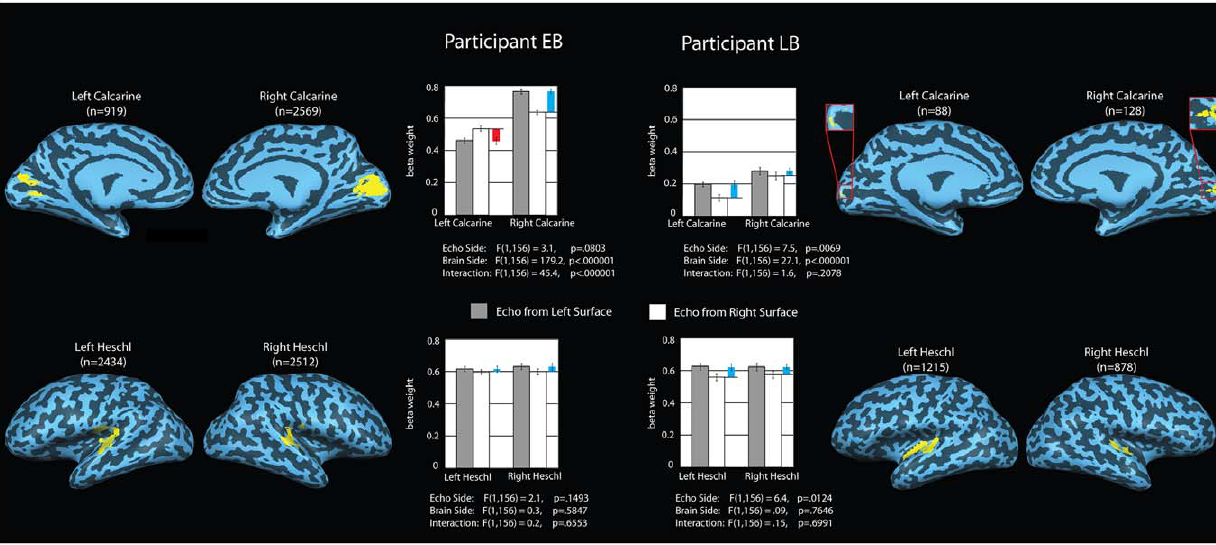
Figure 4. Results of the analysis of contralateral preference for EB and LB. Regions of interest (ROI) were defined based on anatomical and functional criteria. For illustration purposes, we show projections of ROI on the partially inflated cortical surfaces. However, all statistical analyses were performed in volume space. Bar graphs indicate beta values for the various ROIs. Gray and white bars indicate beta weights for ‘echo from surface on left’ and ‘echo from surface on right’, respectively, averaged across voxels within each ROI. Colored bars denote the difference between beta weights within each brain side (red bars indicate higher beta values for ‘echo from surface on right’; blue bars the reverse). Error bars denote SEM. To determine if activity during echolocation exhibits a contralateral preference, we applied independent measures ANOVA to the beta weights with ‘echo side’ (i.e. ‘echo from surface on left’ vs. ‘echo from surface on right’) and ‘brain side’ (e.g. ‘left calcarine’ vs. ‘right calcarine’) as factors to each ROI. ANOVA results are summarized below each bar graph. Results show that activity in calcarine cortex exhibits contralateral preference for EB (significant interaction effect), but not LB. Activity in auditory cortex shows neither contra- nor ipsilateral preference in either subject. For both EB and LB, beta values in the right calcarine exceed those in the left calcarine (main effect of ‘brain side’).